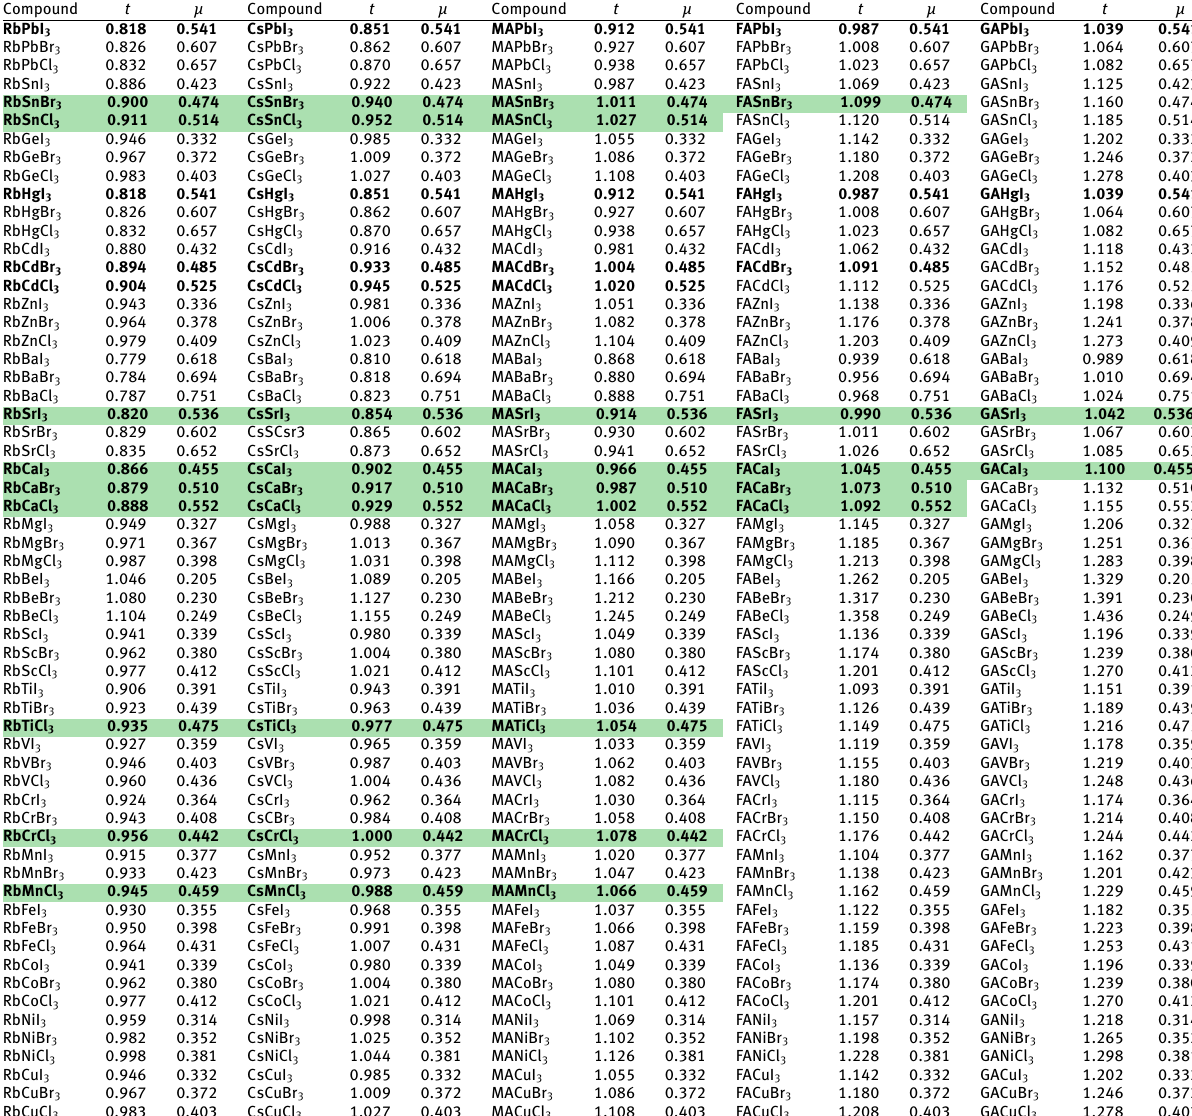
Table 1: The t - and µ -factors of RbBX 3 , CsBX 3 , MABX 3 , FABX 3 , and GABX 3 . Compound